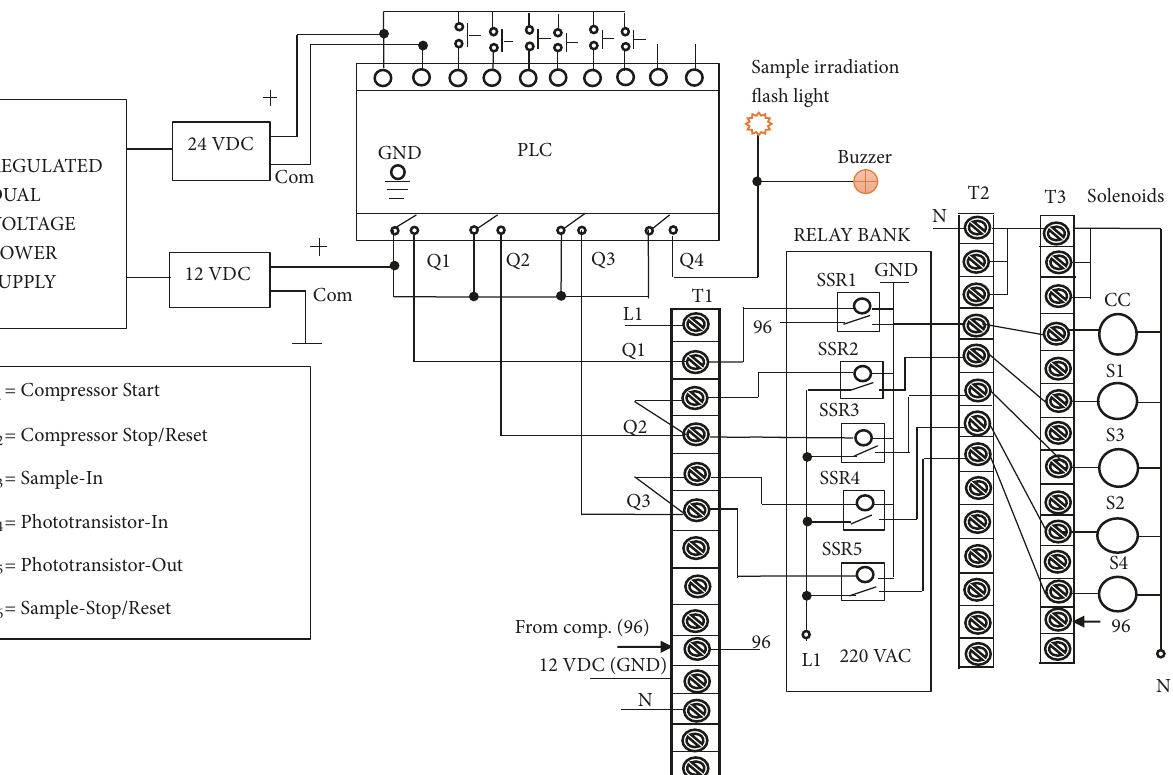
Figure 7: Schematic diagram of the designed PTS controller unit.